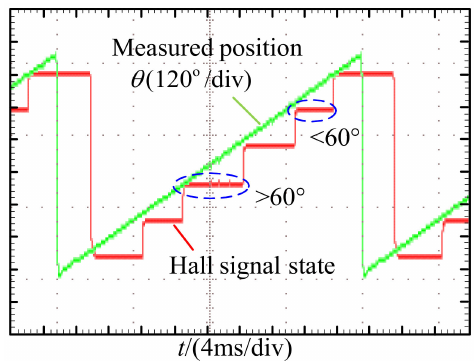
Figure 13. The deviation of the Hall signal state.